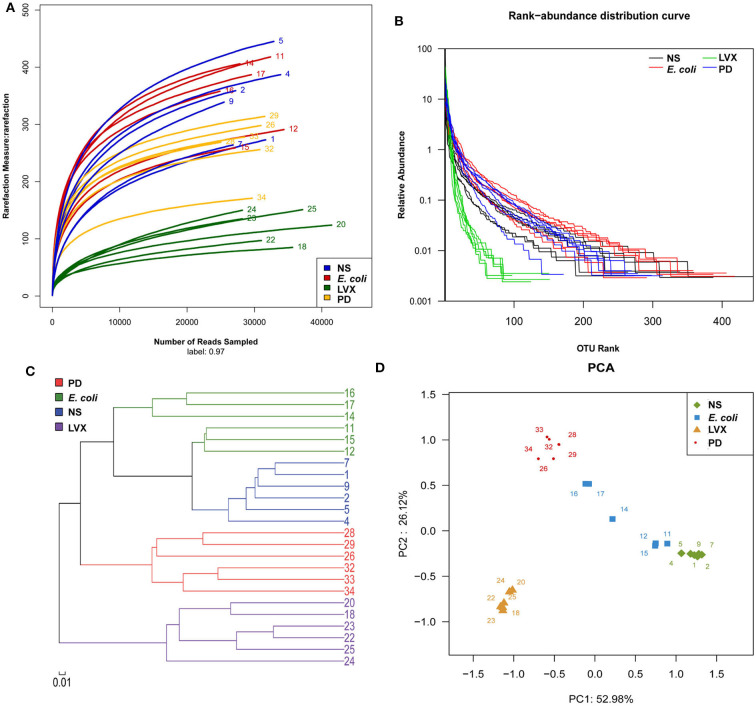
Overall structural and modulation of gut microbiota after PD or LVX treatment. (A) The richness and diversity of rats' fecal microbiota among four groups. Rarefaction curves were used to estimate richness (at a 97% similarity level) of rats' fecal microbiota. (B) Rank abundance curve was used to estimate the abundance and evenness. (C) Difference and similarity of microbial communities among four groups revealed by Weighted Uniface principal component analysis (PCA). (D) Hierarchical cluster analysis.